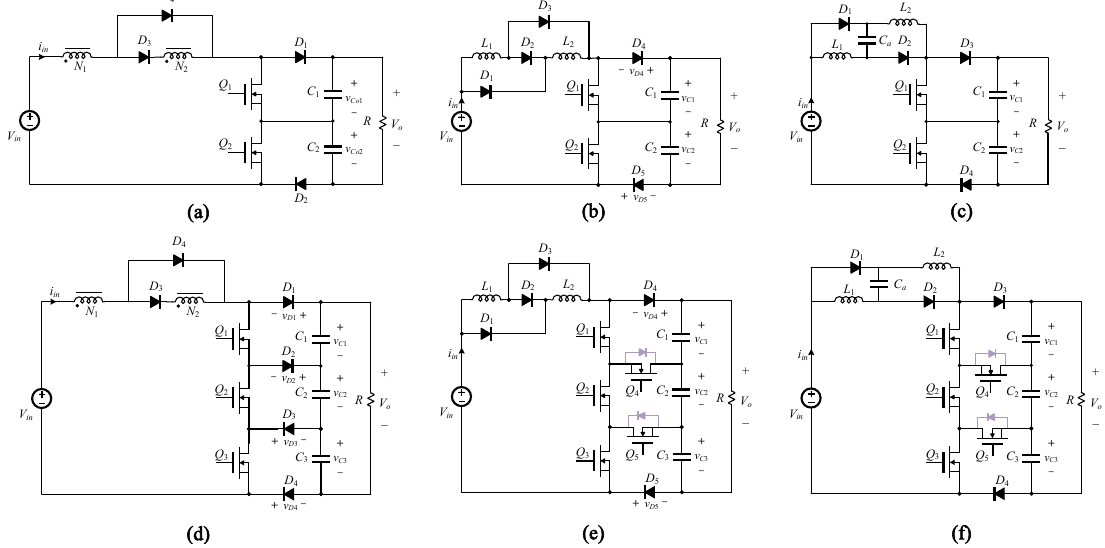
Figure 3. Hybridization of the high voltage cells with multilevel boost converters: ( a ) three-level boost with coupled inductors; ( b ) three-level boost converter with switched-inductor Cell A; ( c ) three-level boost converter with switched-inductor Cell B; ( d ) four-level boost converter with coupled inductors; ( e ) four-level boost converter with switched-inductor Cell A; ( f ) four-level boost converter with switched-inductor Cell